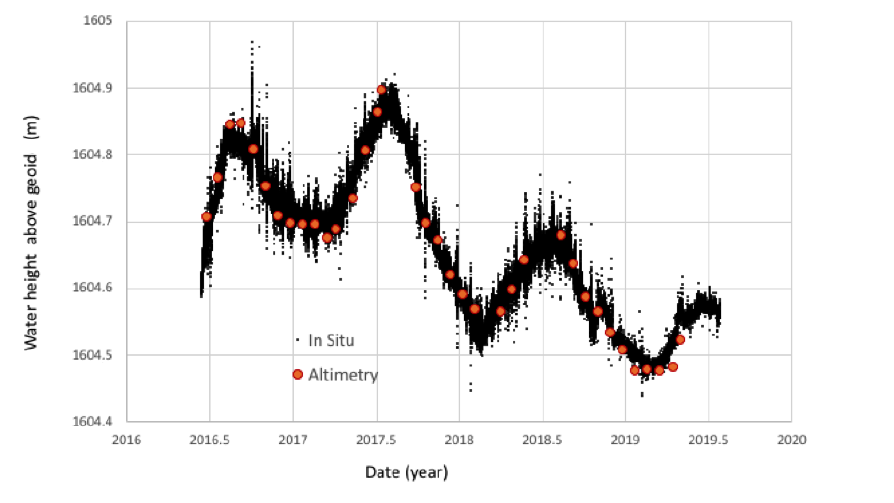
Figure 44. Water height time series using the limnigraph in Karabulun and Sentinel-3A.